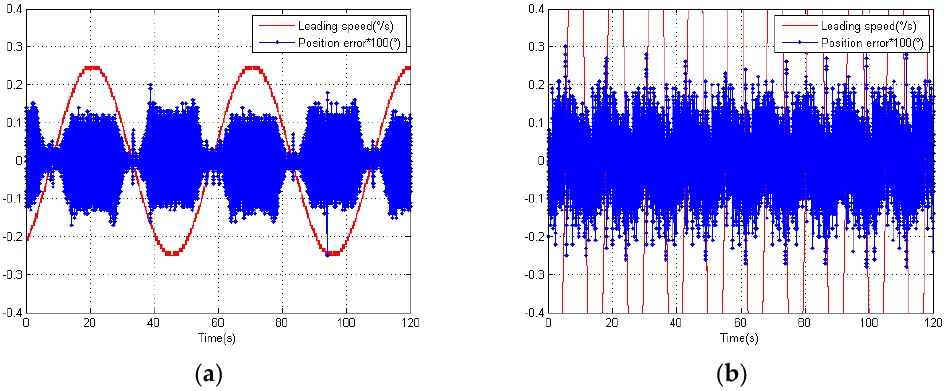
Figure 11. ( a ) Distribution of the position error with leading speed of 0.25°/s; ( b ) Distribution of the position error with leading speed of 1°/s.